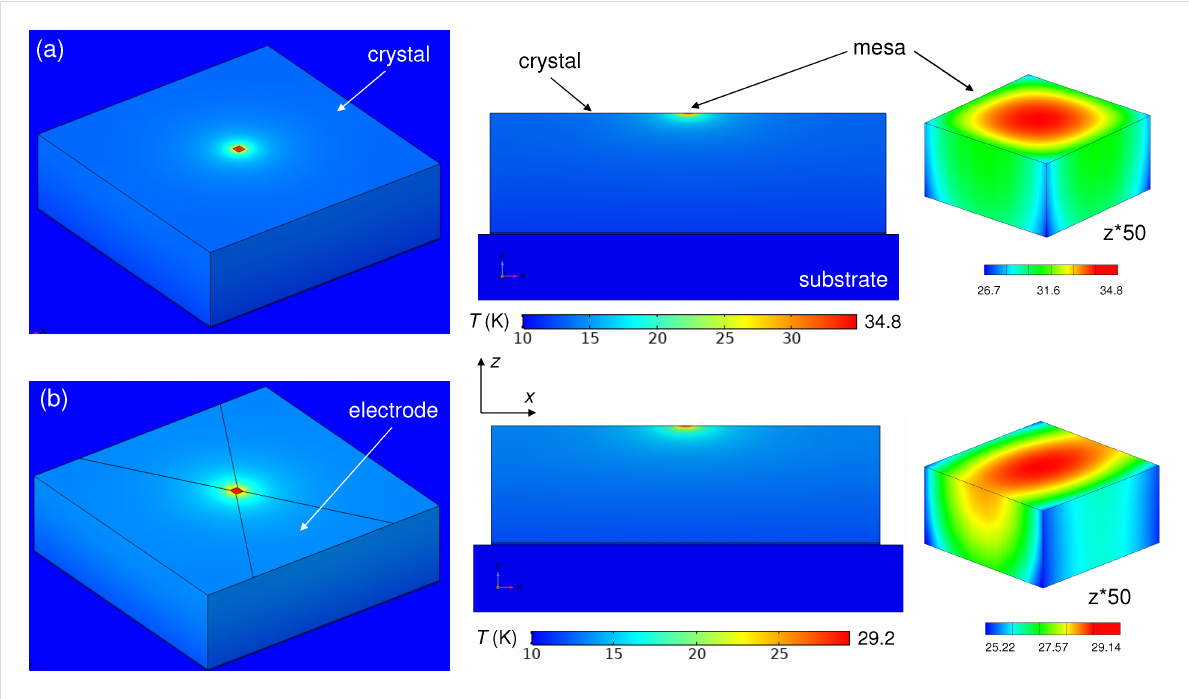
Figure 5: Heat transport in a crystal-based device in vacuum (a) without electrodes, (b) with electrodes. The left panels represent top views, the middle panels the x – z cross section through the mesa, and the right panels the mesa (expanded by factor of 50 in the z -direction).